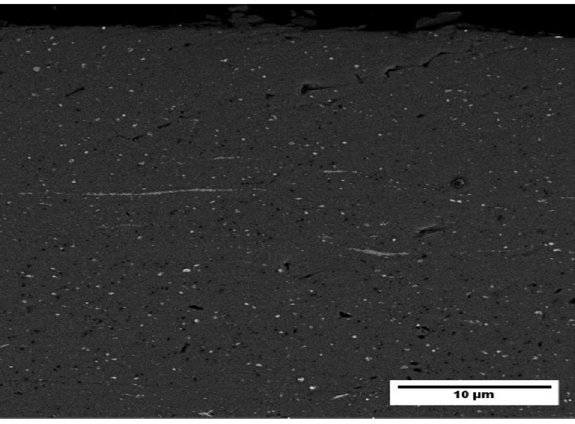
Figure 5: SEM cross - section of the composite sample after the fourth cycle reinforced with 10 Vol% of alumina.